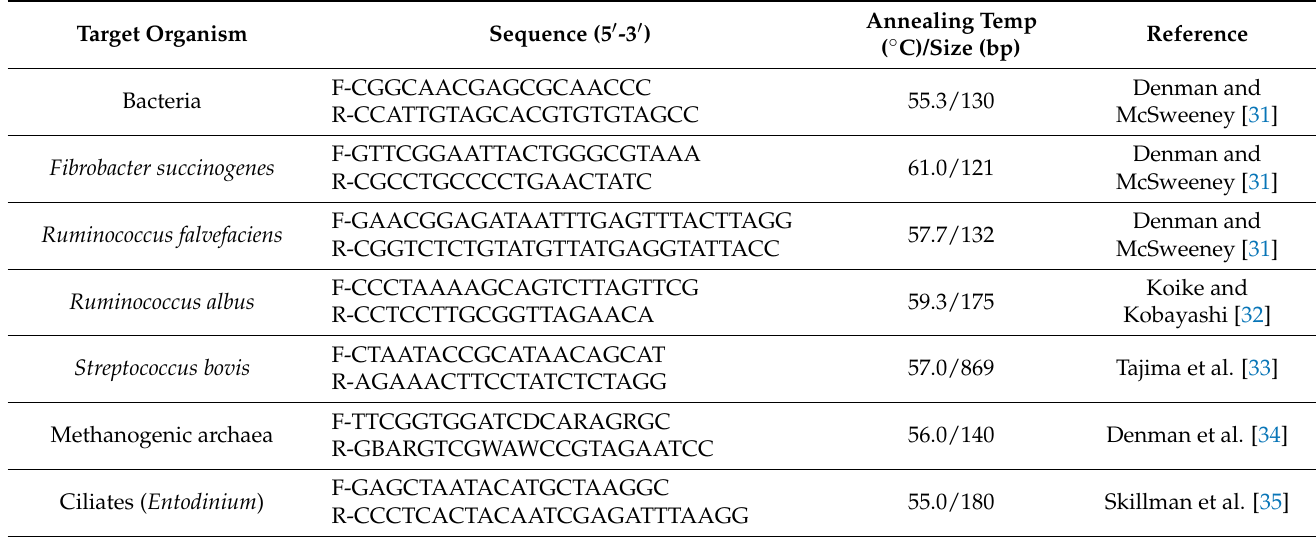
Table 2. Oligonucleotide primers used for Real-Time PCR